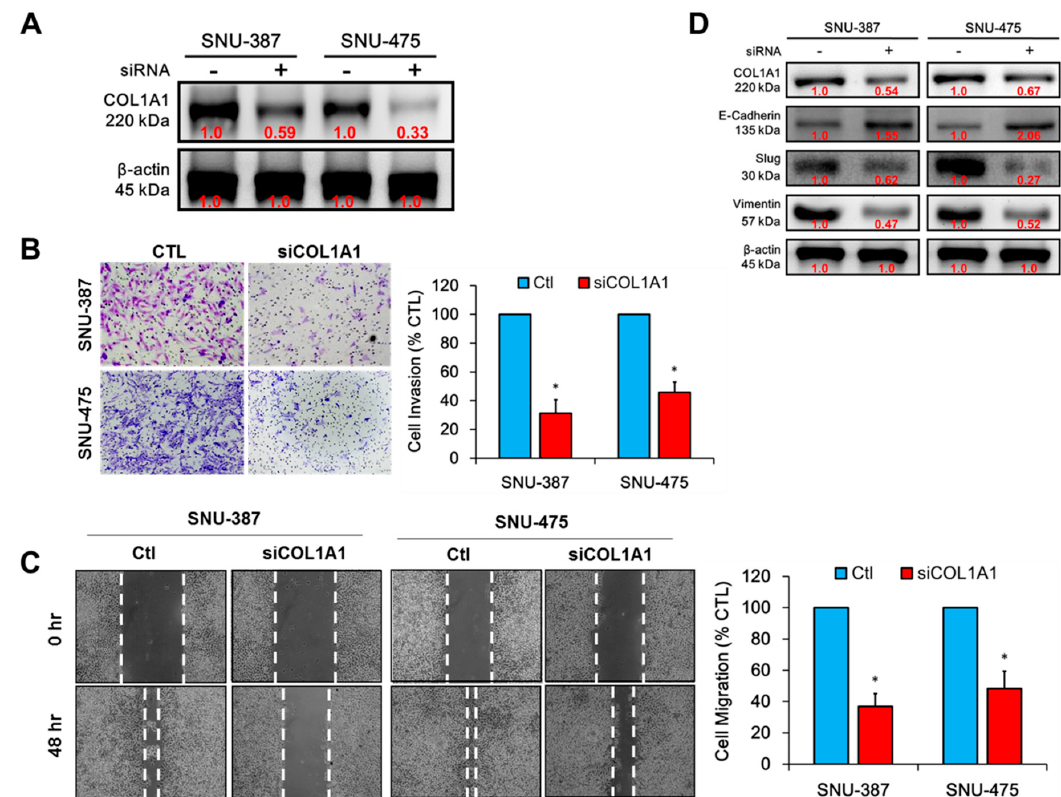
Figure 3. Knockdown of COL1A1 suppressed HCC cell migration and invasion through deregulated epithelial–to–mesenchymal transition (EMT), in vitro. ( A ) Western blot images showing the knockdown efficacy of COL1A1 in SNU-387 or SNU-475 cells. Representative photo-images (left) and histograms (right) of the effect of siCOL1A1 on the ( B ) invasion (scale bar = 100 μ m, original magnification ×200) and ( C ) migration of SNU-387 and SNU-475 cells, magnification ×200. ( D ) Representative Western blot images of the effect of siCOL1A1 on the expression levels of COL1A1, E-cadherin, Slug and vimentin protein in SNU-387 and SNU-475. β -actin was used as a loading control. * p < 0.05; Ctl, wild type cells not transfected with siCOL1A1.